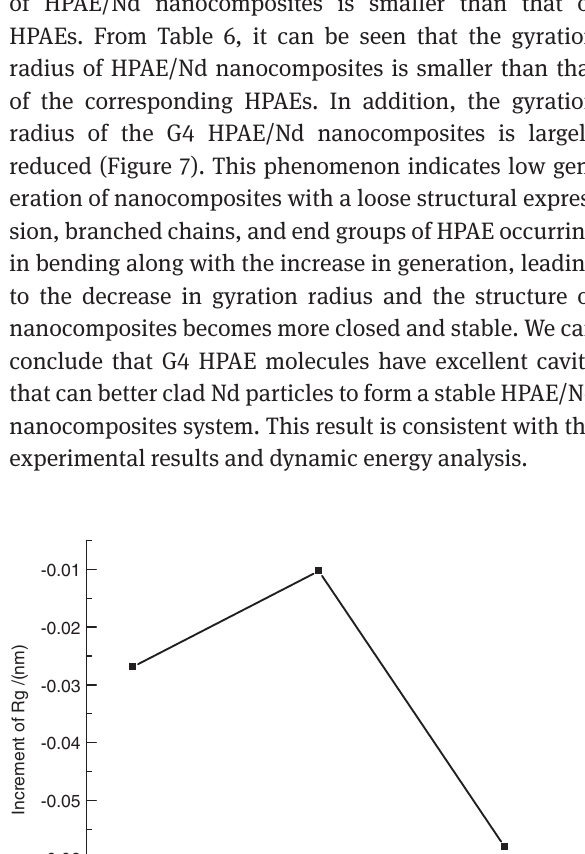
Figure 6D indicates the charges of system redistribu- tion as a whole after insertion of Nd particles. This kind of